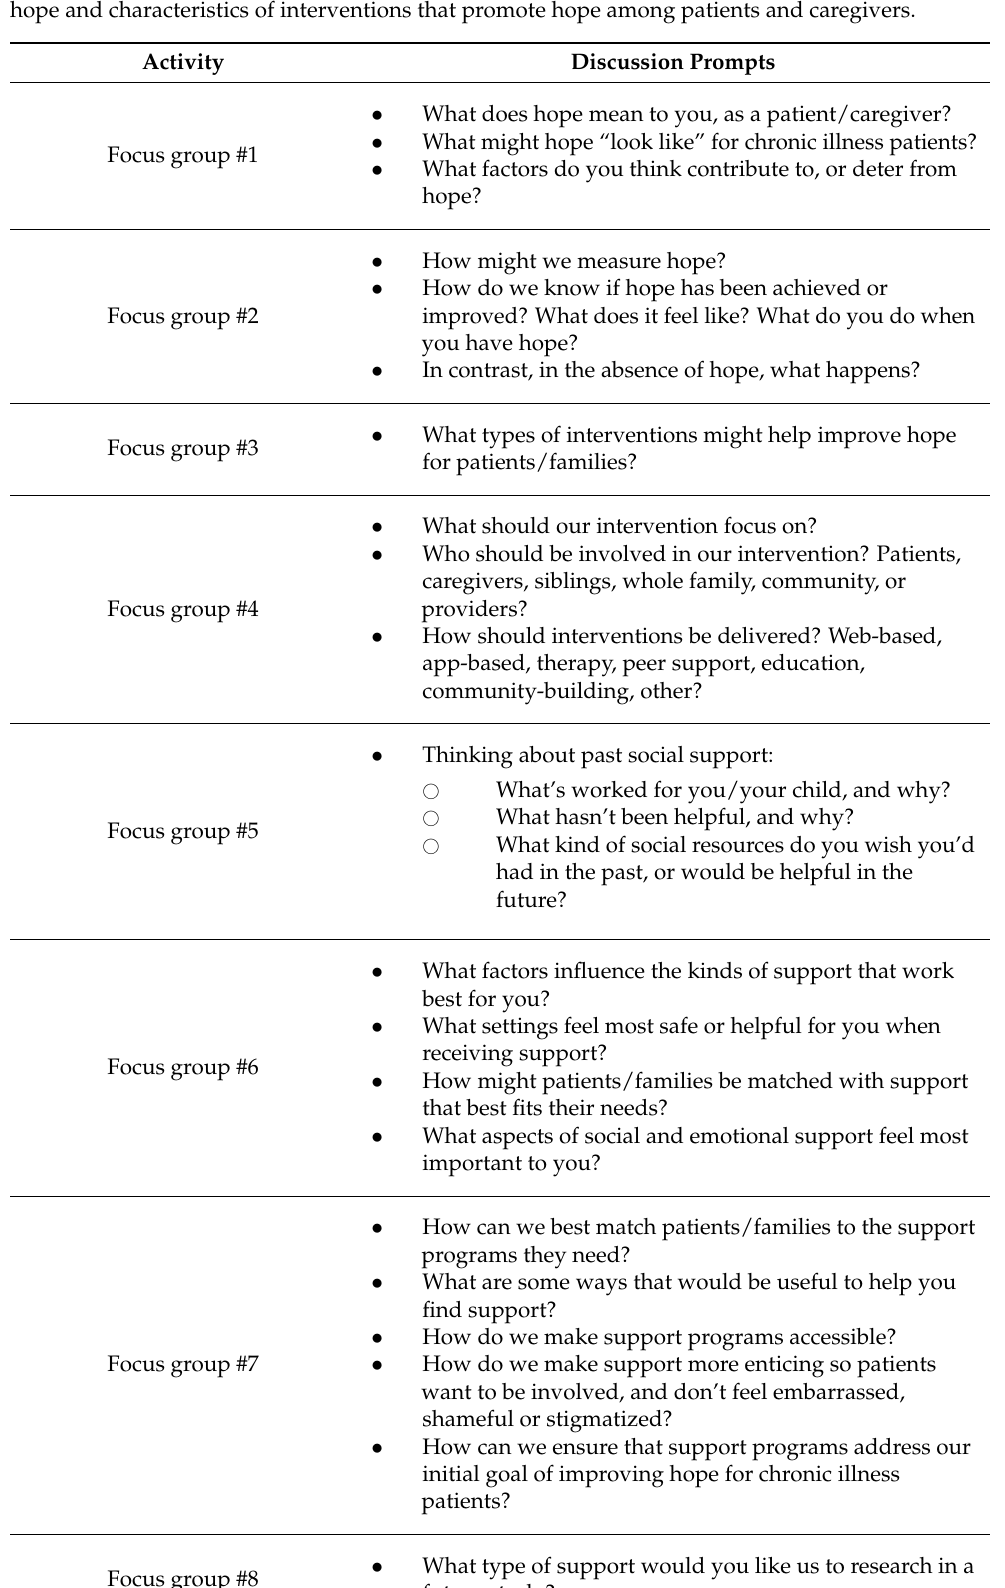
Table 1. Description of discussion prompts used at each virtual focus group to explore the concept of hope and characteristics of interventions that promote hope among patients and